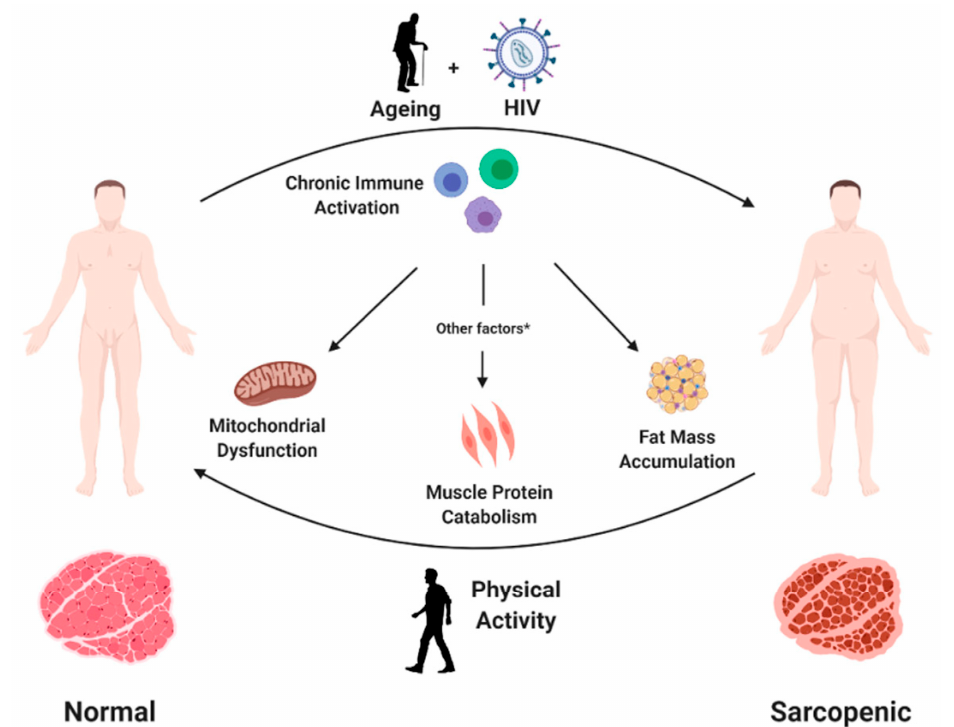
Figure 1. Persistent HIV infection and ageing contribute to development of sarcopenia in people with HIV. Chronic immune activation, common to both conditions, may favour this process through mitochondrial dysfunction, increased muscle protein catabolism and muscle fat